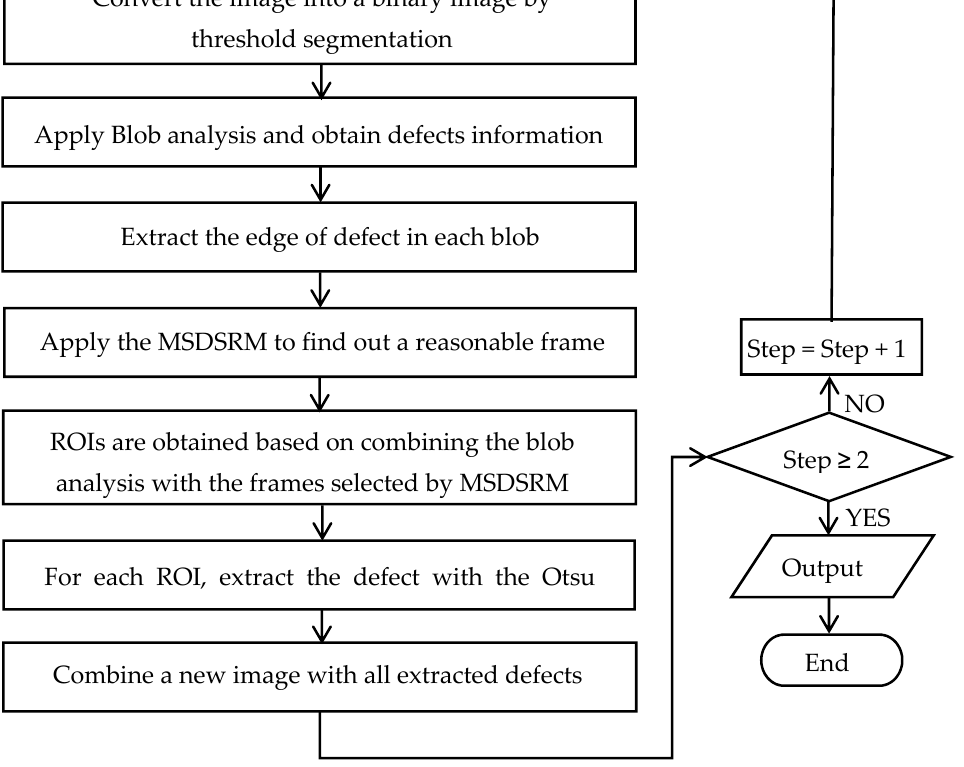
Figure 4. Block diagram for extraction of defects automatically and accurately.